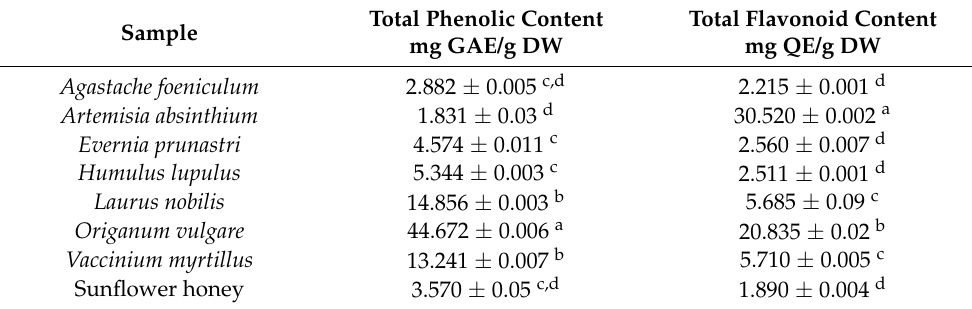
Table 1. Total phenolic and flavonoid content of the different plant extracts and sunflower honey. Results are given as mean values of three independent replicates ± standard